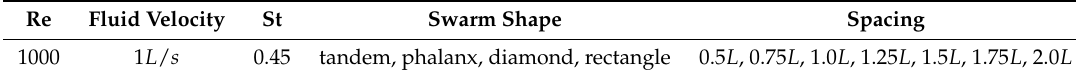
Figure 8. Results of the thrust and drag of each fish at each spacing: ( a ) the diamond swarm, ( b ) the rectangle swarm. Table 3. The experimental